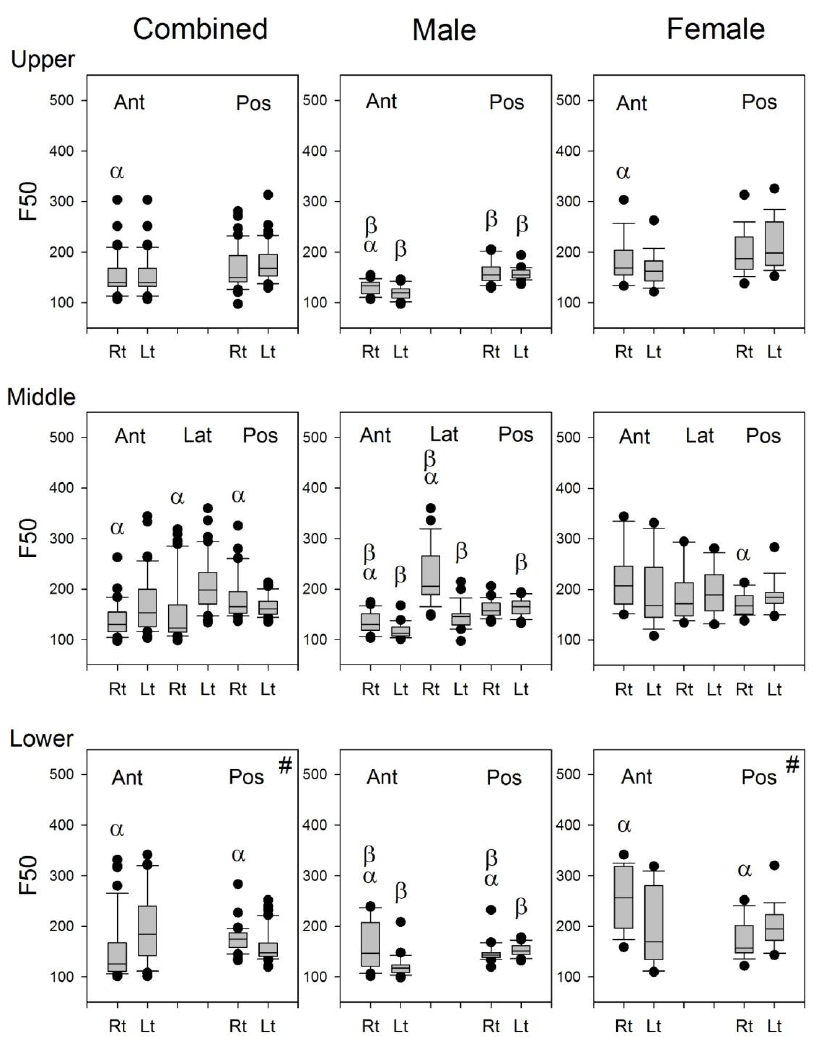
Figure 8. The boxplots of F 50 in the combined group, male group, and female group. #: Three of the 18 female subjects were excluded from the statistics because of excessive artifacts at this site. α : p < 0.05 between right and left lungs; β : p < 0.05 vs. its counterpart in the female subjects. Ant: anterior; Pos: posterior; Lat: lateral; Rt: right, Lt: